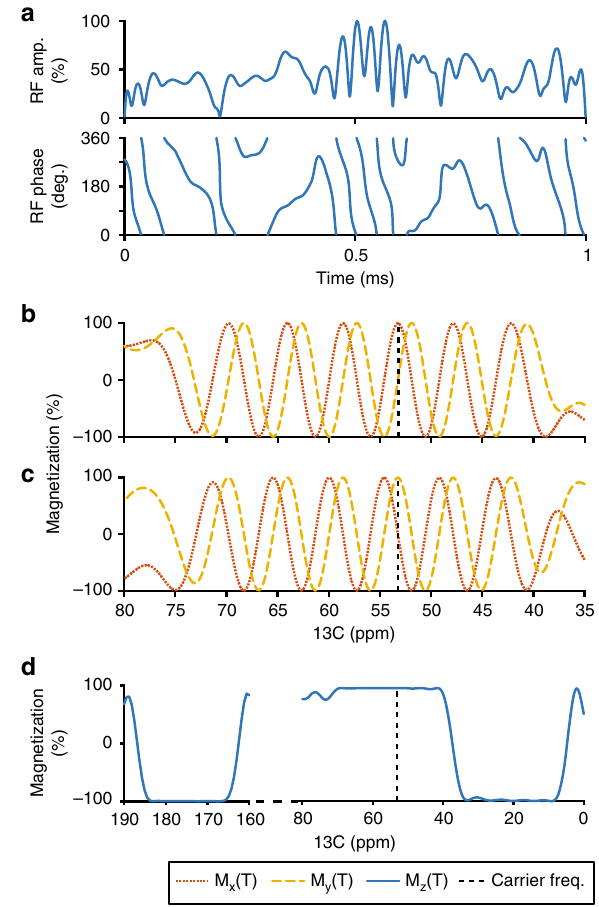
Fig. 2 RF pro fi le and simulation of BADCOP1. a The shaped pulse “ BADCOP1 ” RF amplitude and phase pro fi les. Note that there are no abrupt changes in amplitude or phase. On an 800 Mhz spectrometer the maximum power is 5.94 kHz (100% amplitude) and the duration is 1 ms. For other fi eld strengths, these values can be scaled appropriately to maintain the same bandwidths and fl ip angles. b Simulation assuming an initial state of ρ (0) = I x . We see sinusoidal chemical shift encoding in the transverse plane for the C α region. This behavior was explicitly built into the optimization. Outside of the C α region off-resonance effects take over and the encoding is lost. c Simulation assuming an initial state of ρ (0) = I y also shows encoding. By linearity, the pulse is producing a universal rotation about the z -axis for the C α region, with rotation angle proportional to chemical shift frequency. d Simulation assuming an initial state of ρ (0) = I z . The longitudinal magnetization is inverted for all CO and for C β below about 35 p.p.m. This leads to selective decoupling of resonances in these two regions. The pulse can be run in the middle of an arbitrary-duration indirect encoding period to refocus resonances, without inducing any Bloch –